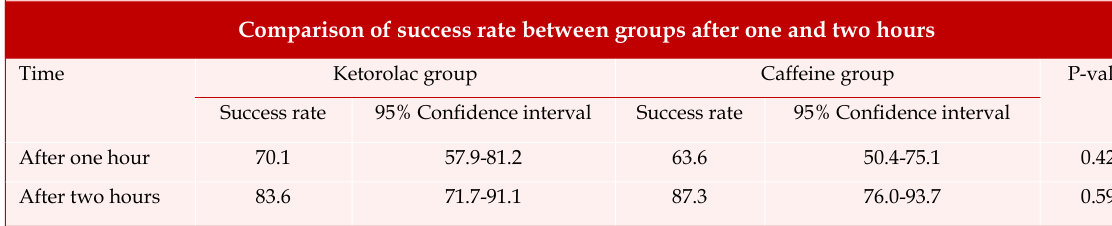
Comparison of success rate between groups after one and two